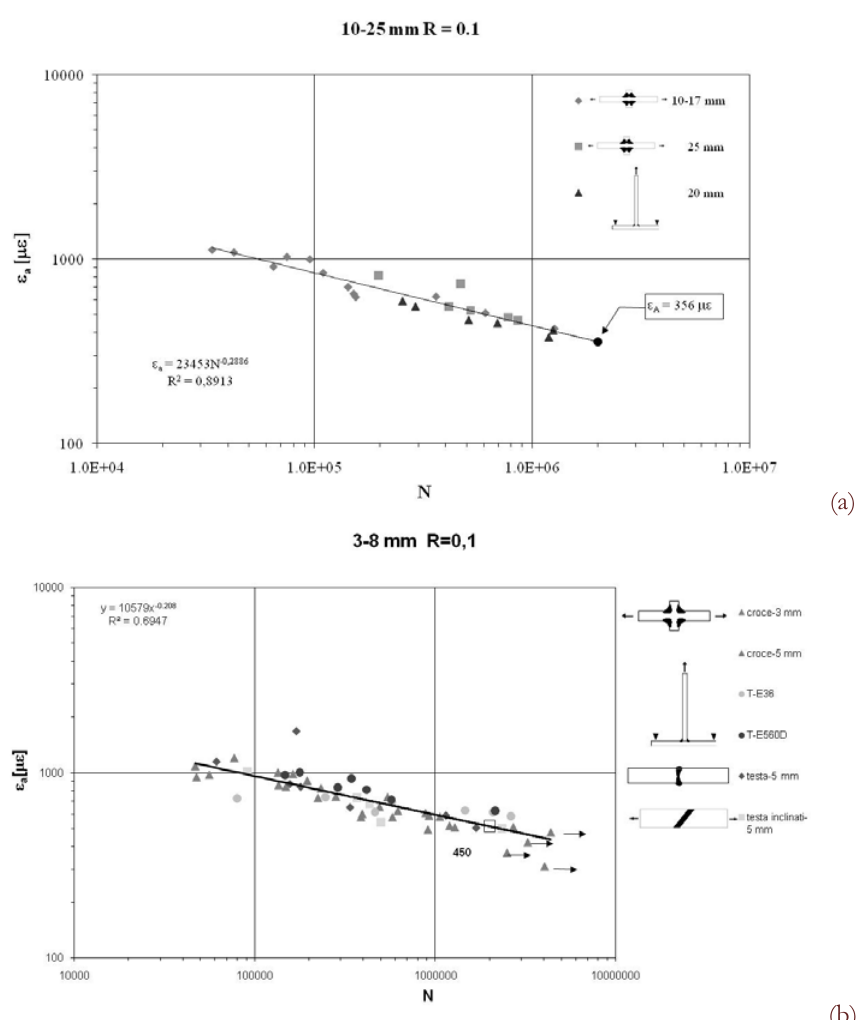
Figura 2: Curve di resistenza a fatica in termini di ampiezza di deformazione locale di giunti saldati in acciaio: a) spessori 10-25 mm; b) spessori 3-8